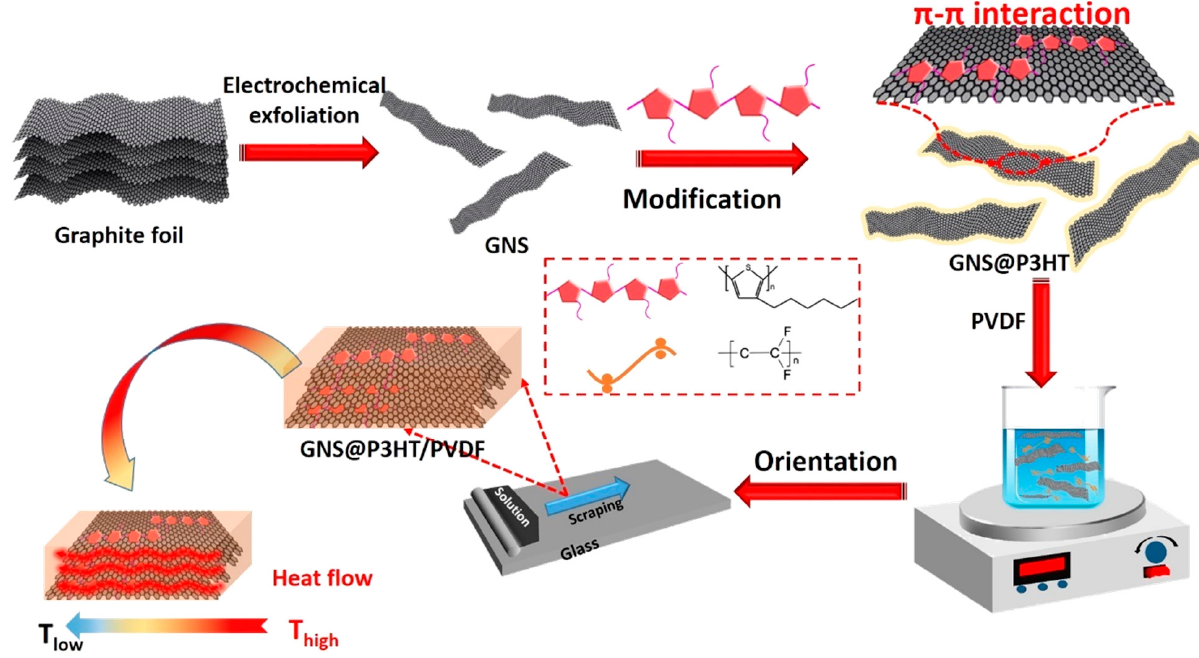
Figure 1. Schematic diagram of the preparation process of Graphene sheets @poly(3-hexylthiophene)/poly (vinylidene fluoride) (GNS@P3HT/PVDF).